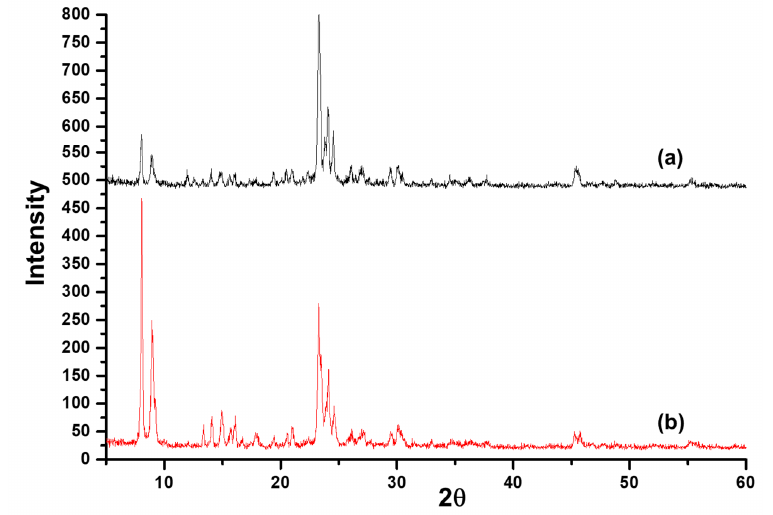
Figure 3. XRD of ( a ) as-synthesized silicalite-1 powder and ( b ) calcined silicalite-1